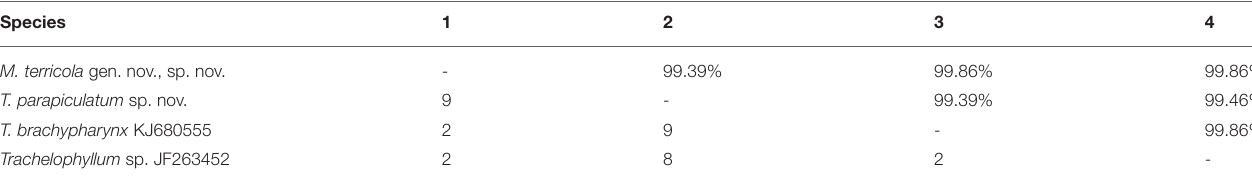
TABLE 2 | Interspecific sequence similarity (above diagonal) and number of nucleotide differences (below diagonal) of the 18S rRNA gene sequences among members of the family Trachelophyllidae.